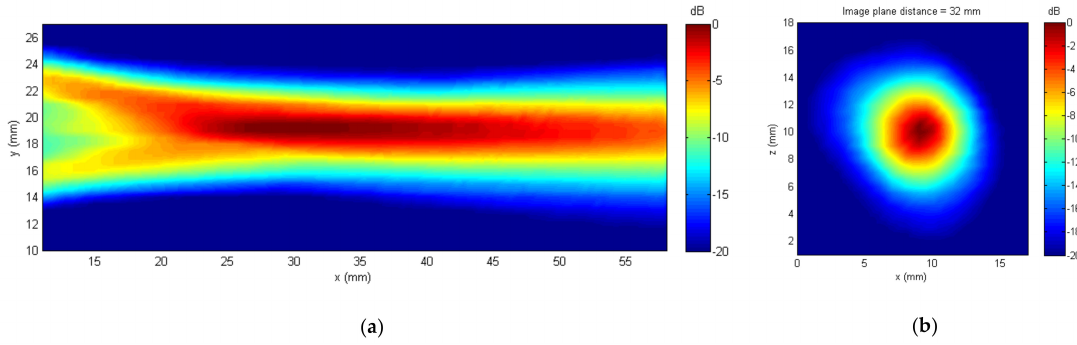
Figure 12. HS03 spherically focused transducer (radius of curvature 35 mm) acoustic field. ( a ) axial section, ( b ) transversal section.